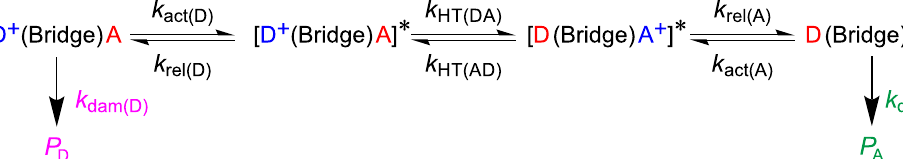
Figure 1. The kinetic scheme for HT in DNA. D + (Bridge)A and D(Bridge)A + indicate the initial and the final state, giving rise to damaged products P D and P A . [D + (Bridge)A]* and [D(Bridge)A + ]* denote the ensembles of structures in which the hole donor and acceptor are in vibronic resonance with each other, so that k HT ( DA ) = k HT ( AD ) ; k HT has been computed by resolving the time dependent Schrödinger equation. k dam ’s and k rel ’s have been inferred from experimental data; no direct information is available for k act